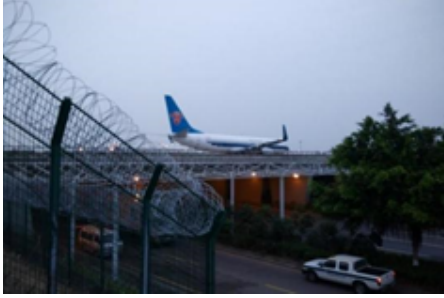
Figure 1. Taxiway bridge entity image.